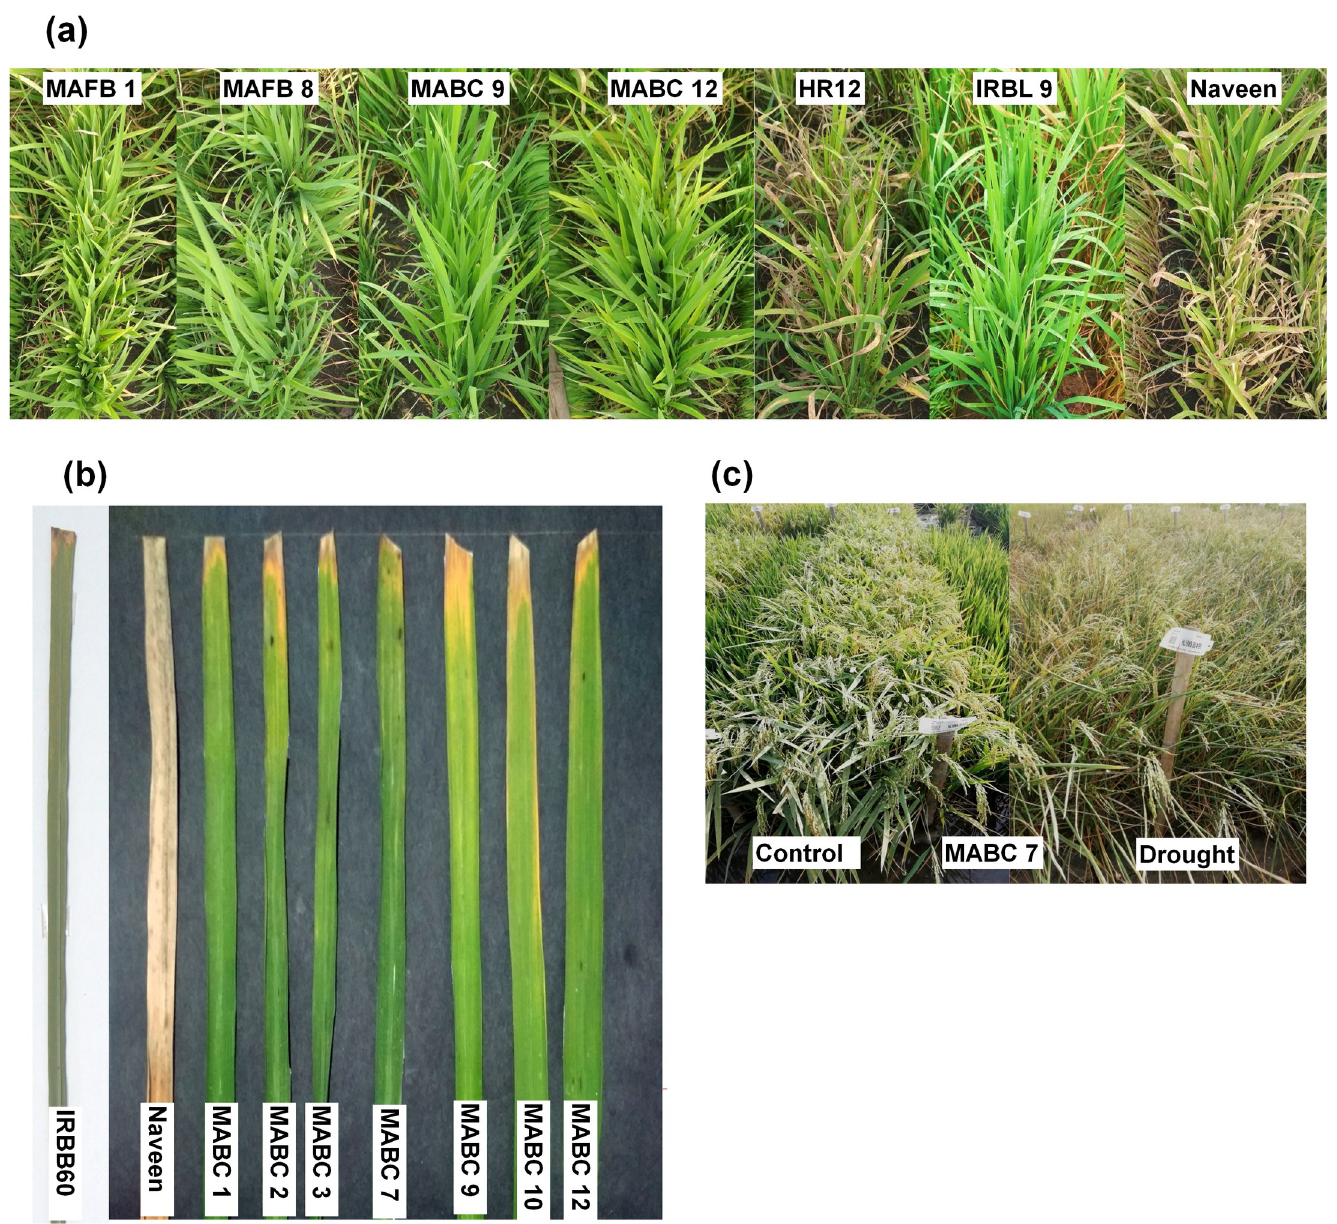
Fig 2. Representative picture of screening of the ILs for blast, BLB, and drought. (a) screening for blast resistance (b) screening for bacterial leaf blight resistance (c) Screening for drought tolerance.